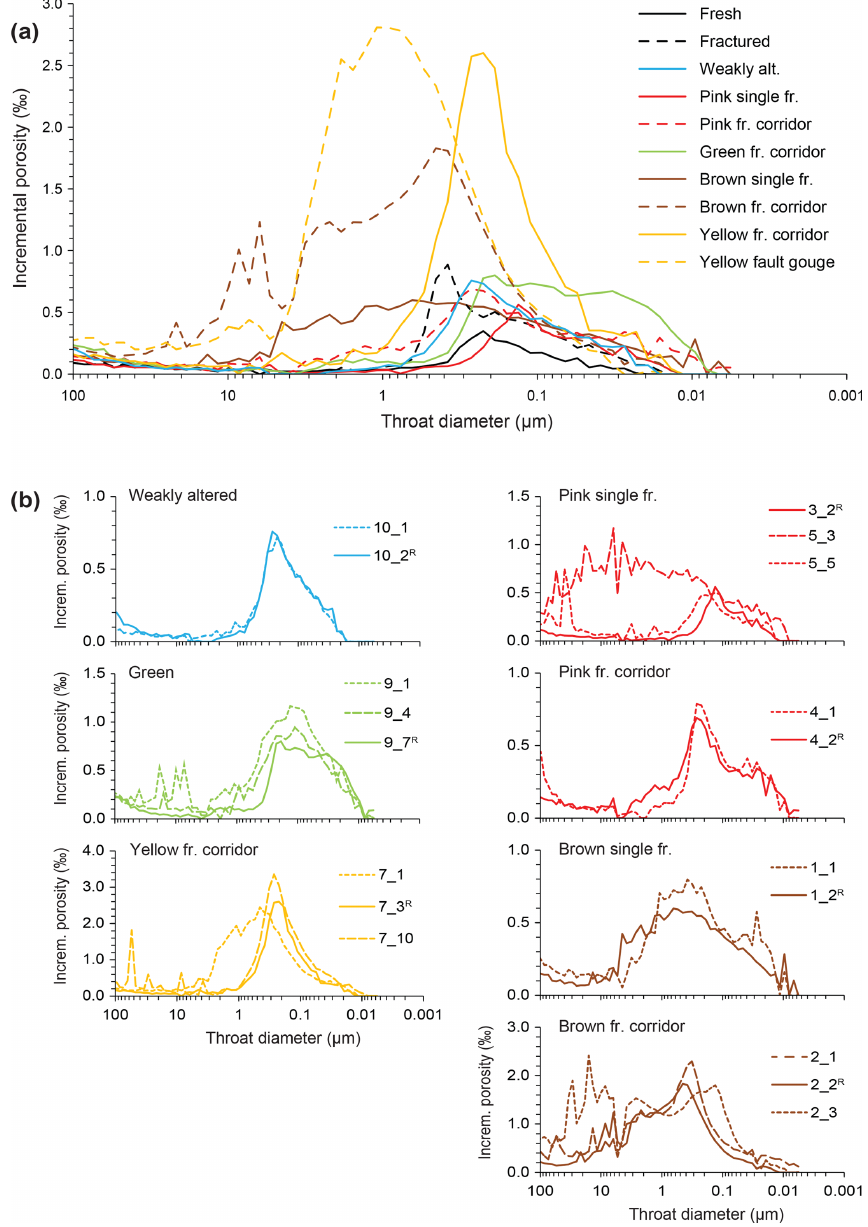
Figure 10. Incremental porosimetric curves showing throat size distributions of the connected porosity of (a) different facies and of (b) specific fracture-related features within the altered facies. From the latter, specimens indexed with “R” were selected as representative of the facies matrix and plotted in (a) , compare with Fig. 3. Fr.: fracture, alt.: